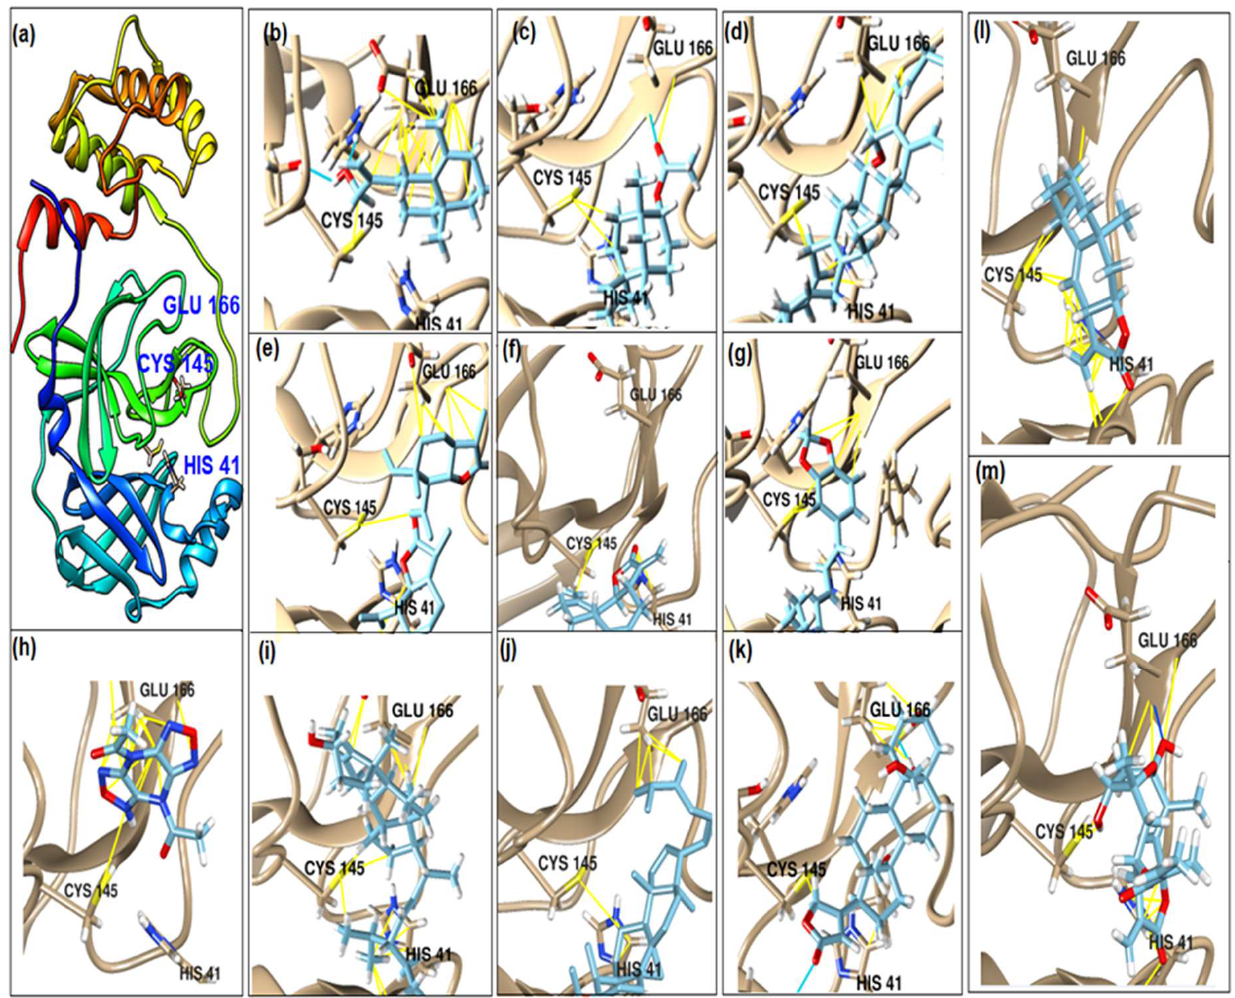
Figure 2. (a) The main protease of the SARS-CoV-2 crystal structure, with a particular focus on GLU 166, CYS 145, and HIS 41 active residues (PDB ID: 6Y2E). Amplified picture of docked compound (a–i,k–m) with the active site of M pro .